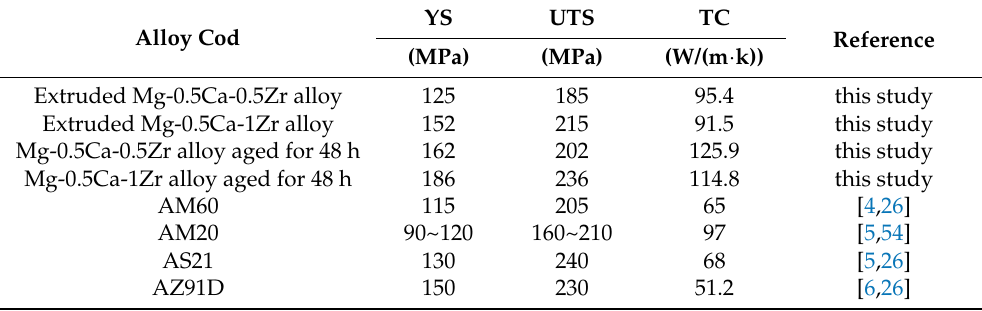
Reference this study